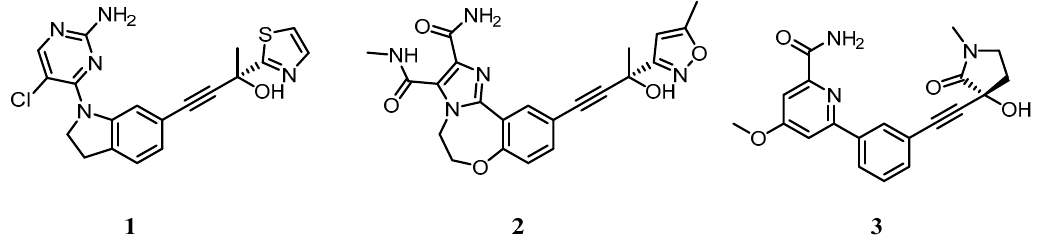
Figure 4. Small molecule inhibitors of NIK developed by Amgen and Genentech. For full chemical names of 1 – 3 see Appendix.